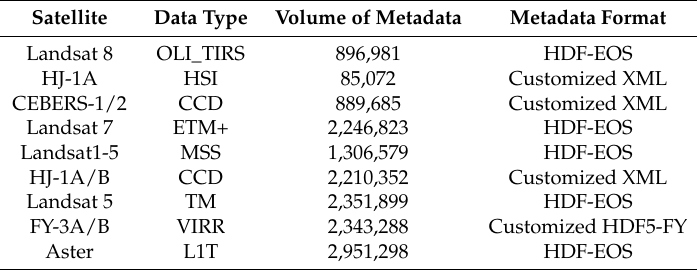
Table 5. A summary of experimental remote sensing metadata.